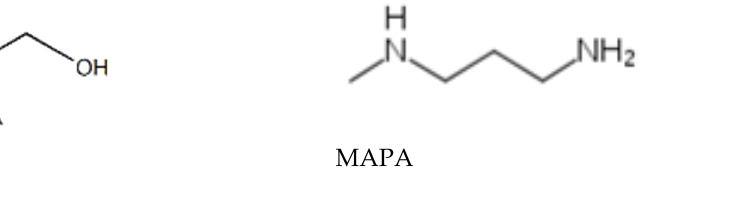
Figure 1. Structure of AMP and MAPA.